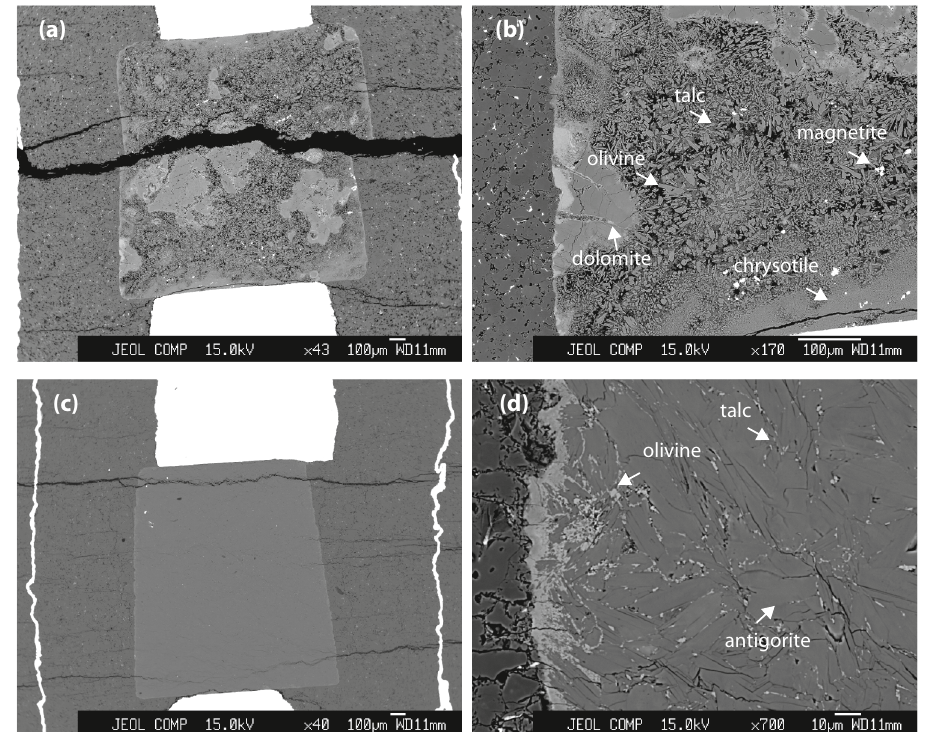
Figure 3. Back Scattered Electron (BSE) images showing the cross-section of the ( a , b ) chrysotile and ( c , d ) antigorite samples after electrical conductivity measurements, cut along the axial direction of the assembly.